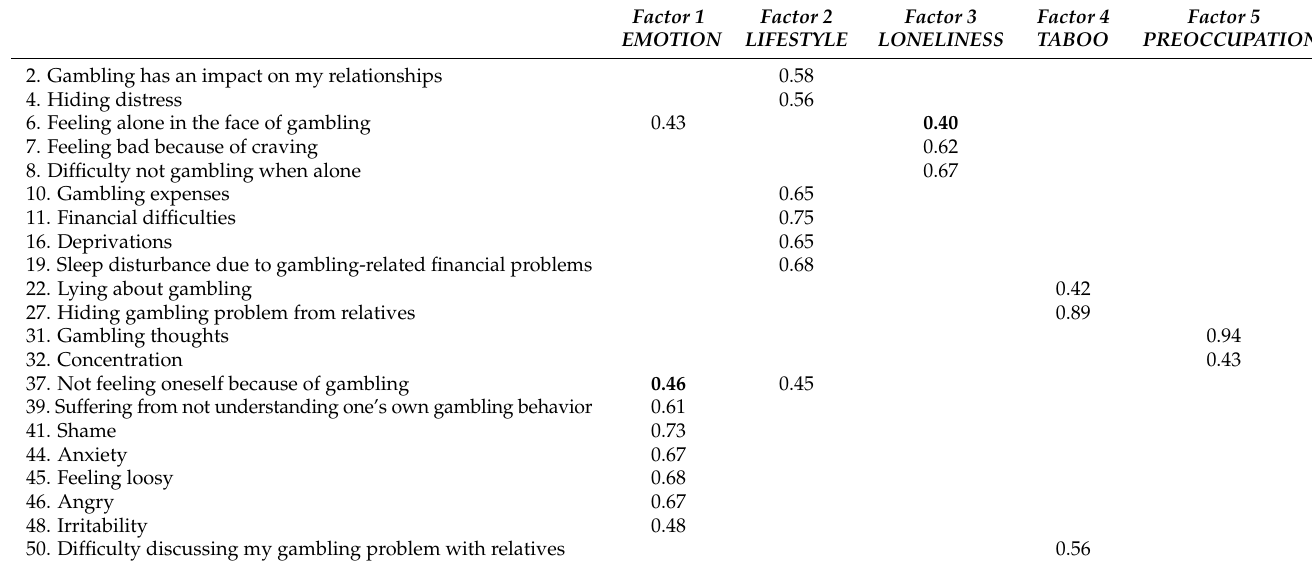
Table 5. GQoLS 5-factor model (Varimax rotation–N = 92). Rotated Factor